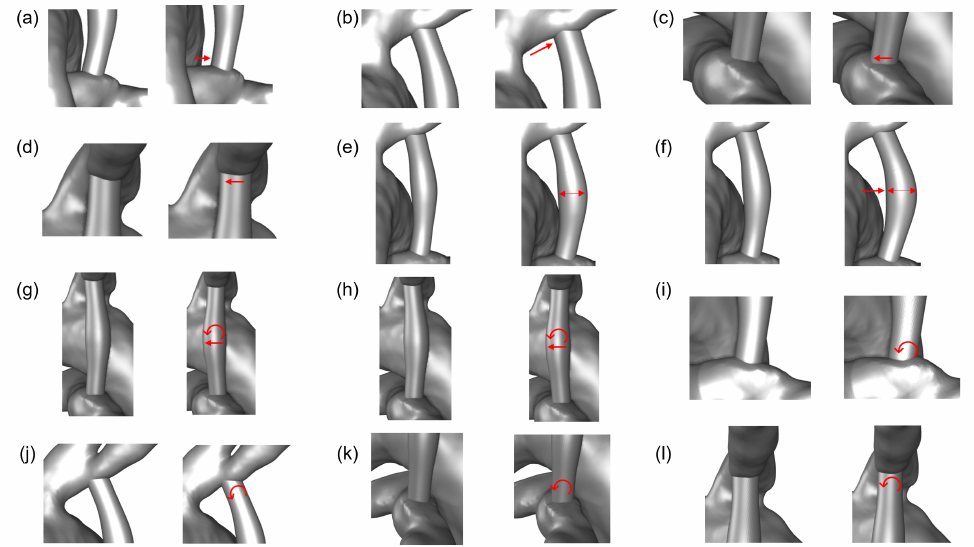
Figure 5. Morphing effect of the twelve RBF shape modifiers: dl-1-vol ( a ); dl-2-vol ( b ); dr-1-vol ( c ); dr-2-vol ( d ); mid-dl-vol2 ( e ); mid-dl-vol ( f ); mid-dr-vol2 ( g ); mid-dr-vol ( h ); rl-1-vol ( i ); rl-2-vol ( j ); rr-1-vol ( k ); rr-2-vol ( l